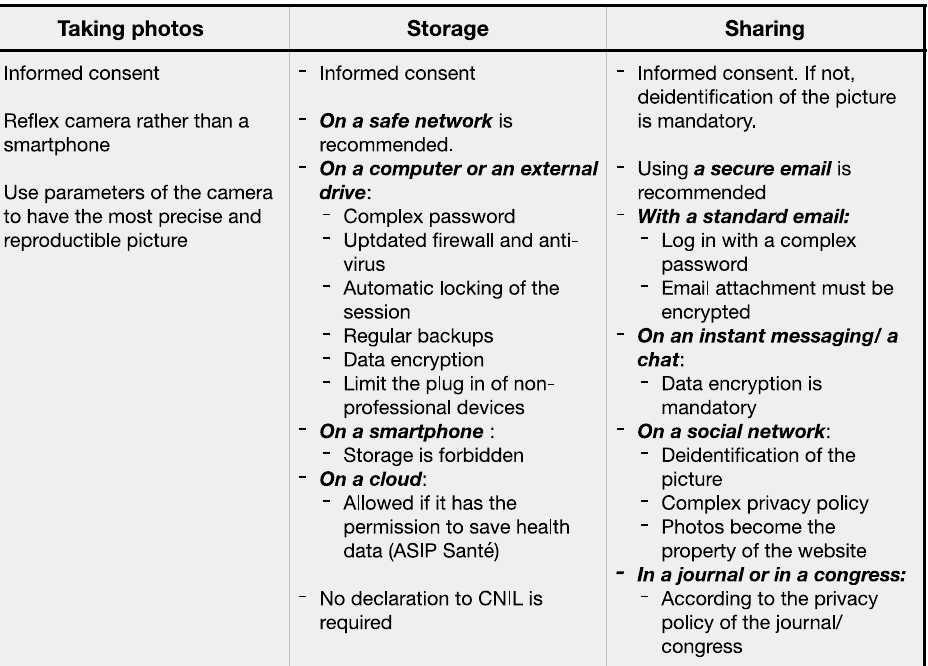
Fig. 4. Best practice recommendations for using photography in oral